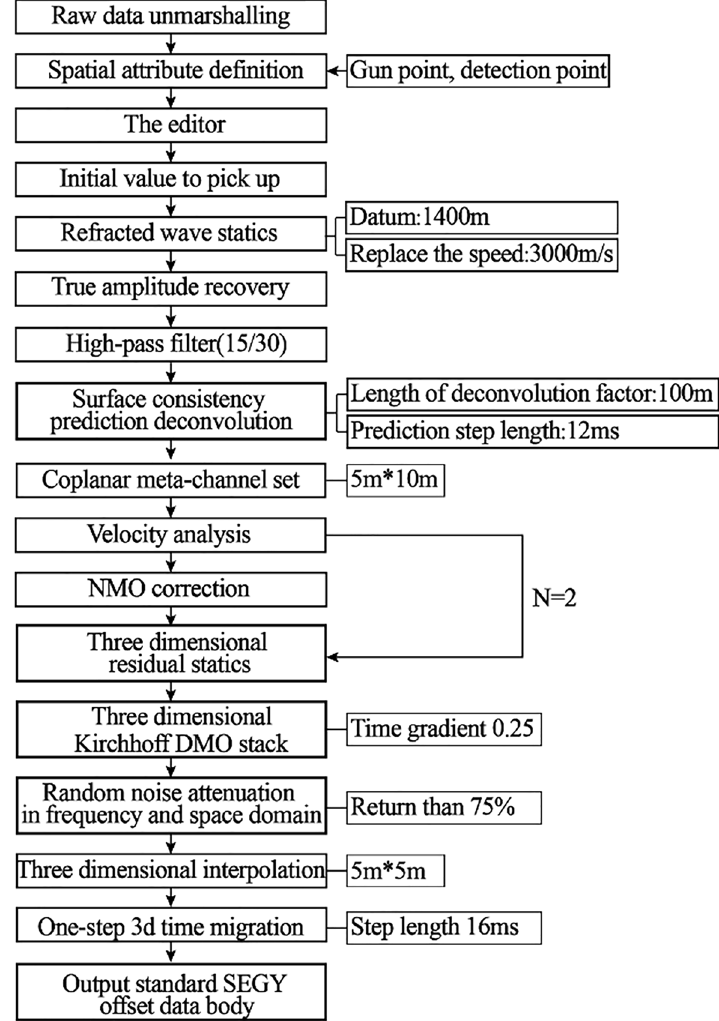
Figure 3. Processing flow chart. process of key parameters processing and analysis.